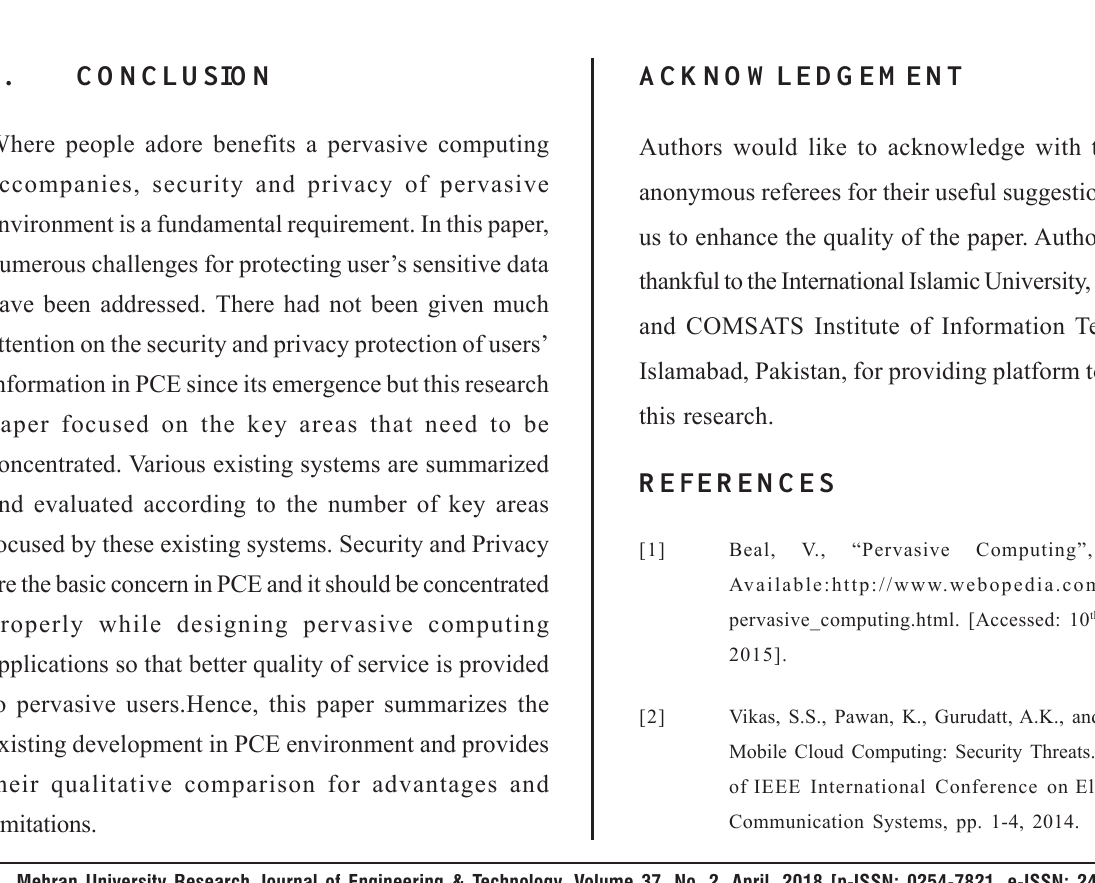
FIG. 3. GRAPH OF AREAS CONCENTRATED BY PCE